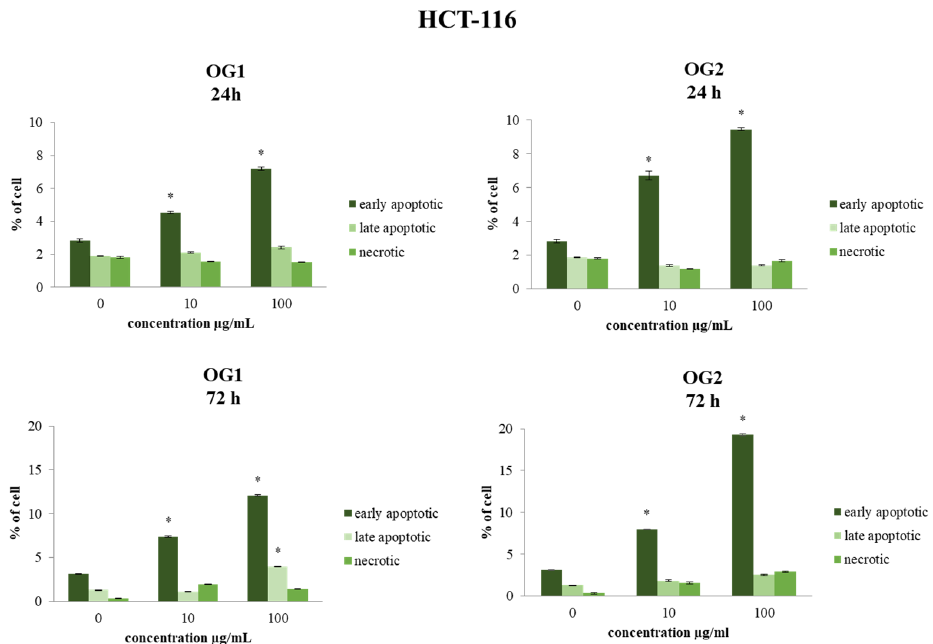
Figure 3. Flow cytometric analysis of Annexin V-FITC/7-AAD stained HCT-116 cells for 24 h and 72 h exposure with essential oils OG1 and OG2 at concentrations 10 µg/mL and 100 µg/mL. The percentages of early apoptotic (Annexin V+7-AAD − , lower right quadrant), late apoptotic (Annexin V+7-AAD+, upper right quadrant) and necrotic cells (Annexin V7-AAD+, upper left quadrant) in nontreated and treated cells are indicated on dot plots. Results are presented as the mean of three independent experiments ± standard error; * p < 0.05 relative to control.